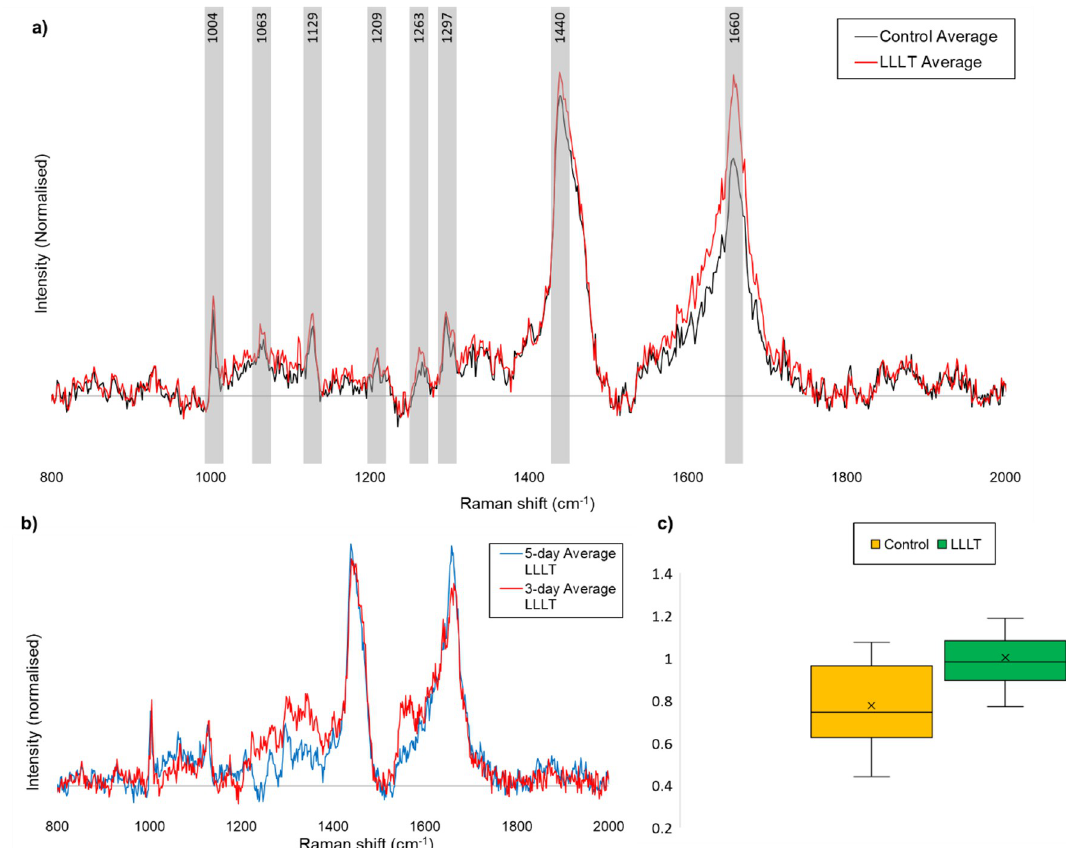
Fig 8. a) Comparative figure of average control and average PBM Raman spectra normalised, illustrating the changes in average intensity of the 1440 and 1660 cm -1 peaks, and highlighting the assigned, characteristic peaks of rat hippocampus. b) Comparative figure of normalised Raman spectra from average 3-day PBM samples and average 5-day PBM samples, no significant difference was observed between the 1660 cm -1 /1440 cm -1 peak ratios at each therapeutic interval (p = 0.4). c) Box and Whisker plot illustrating the increase in average peak intensity ratio of 1660 cm -1 /1440 cm -1 , increasing from 0.774 for control samples to 1.002 for PBM samples (p =